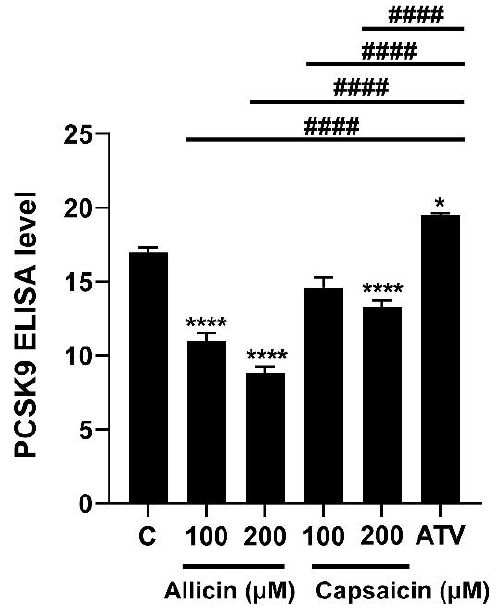
Figure 6. Effects of allicin (100, 200 µM), capsaicin (100, 200 µM), and atorvastatin (10 µM) on PCSK9 expression in HepG2 cells. The PCSK9 levels in culture medium were determined by ELISA. The data represent the mean ± SEM of three independent experiments ( N = 3) . * p < 0.05, and **** p < 0.001 represent significant differences compared to the vehicle-treated cells or the control group (C); #### p < 0.001 represent significant differences compared to atorvastatin (ATV)-treated cells. ns: not significant.